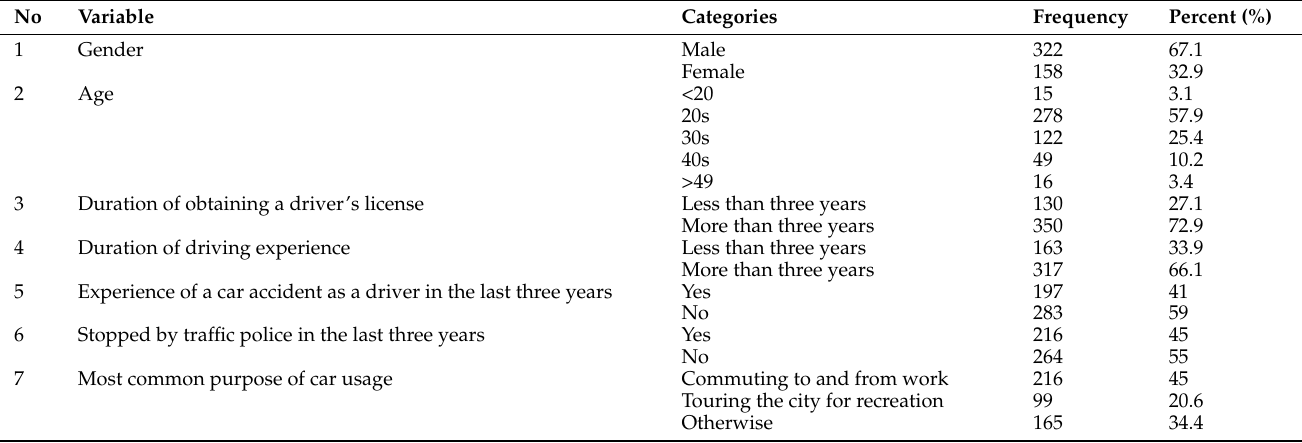
Table 1. Descriptive statistics of demographic and driving-related